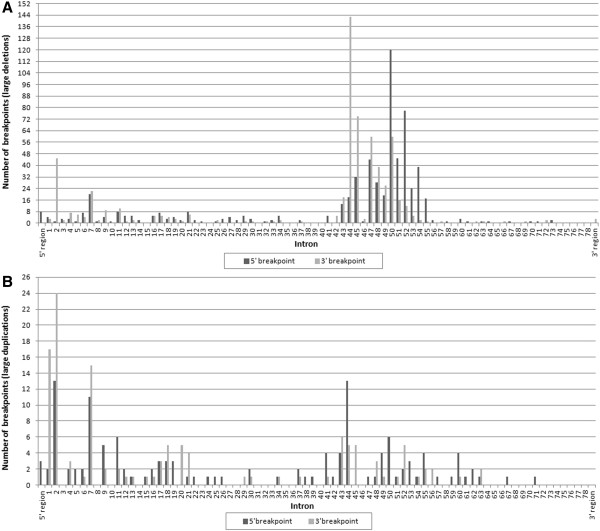
Distribution of intronic breakpoints of large rearrangements within the DMD gene. (A) Intronic deletions breakpoints and (B) Intronic duplications breakpoints. The number of starting breakpoint (5′ breakpoint) and ending breakpoint (3′ breakpoint) of either deletion or duplication localized in each intron is indicated.